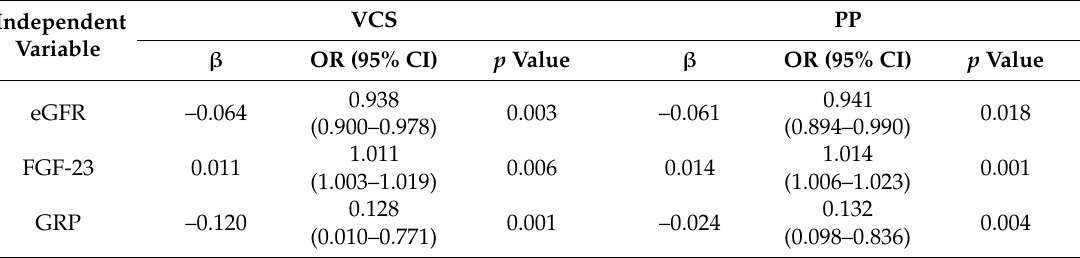
Table 5. GRP is significantly associated with vascular calcification score (VCS) and pulse pressure (PP).